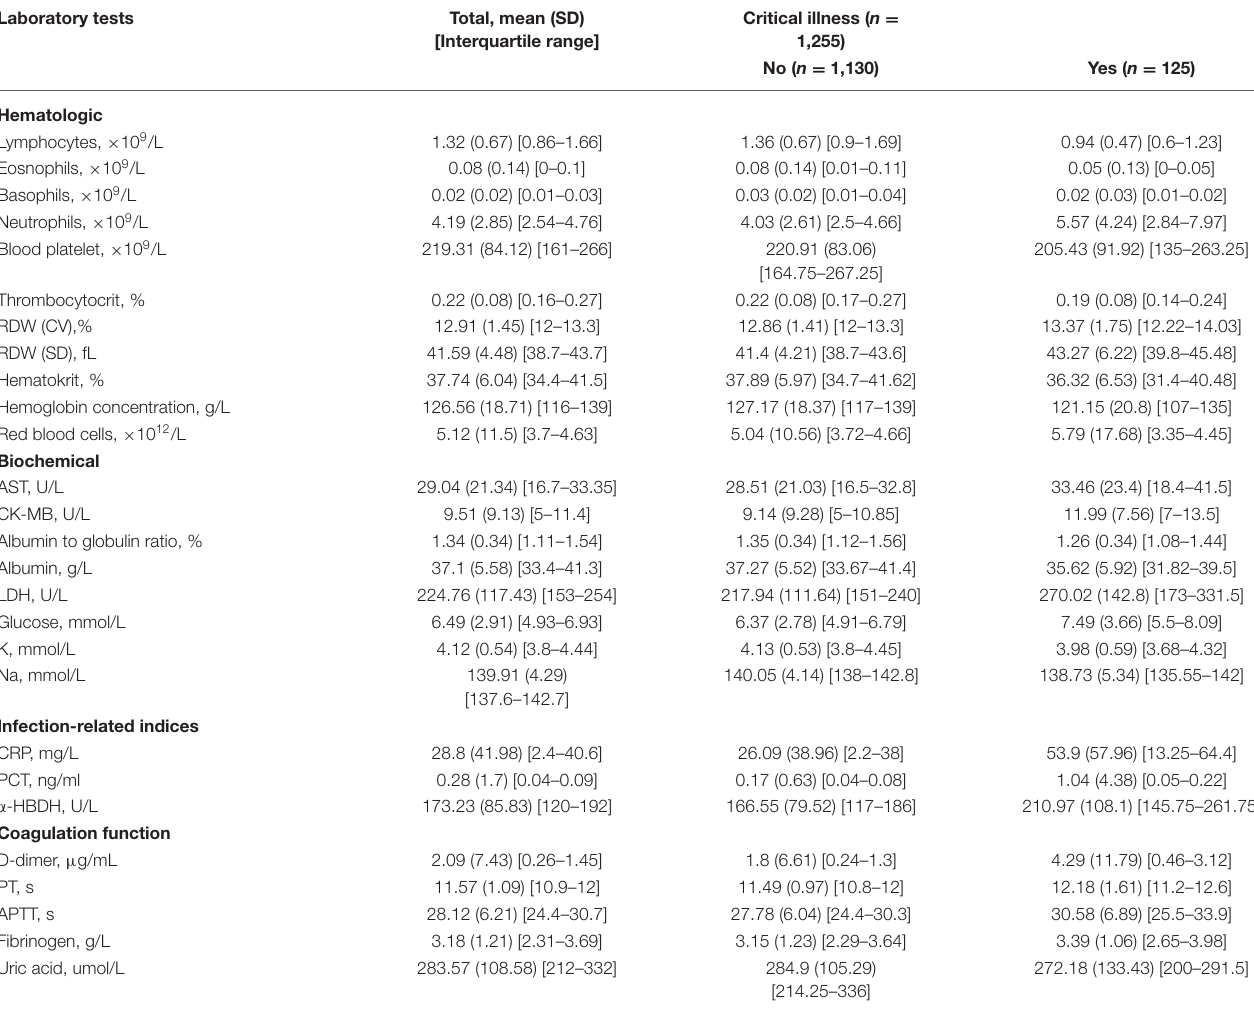
TABLE 1 | Laboratory characteristics among patients who did not or did develop critical illness in the development